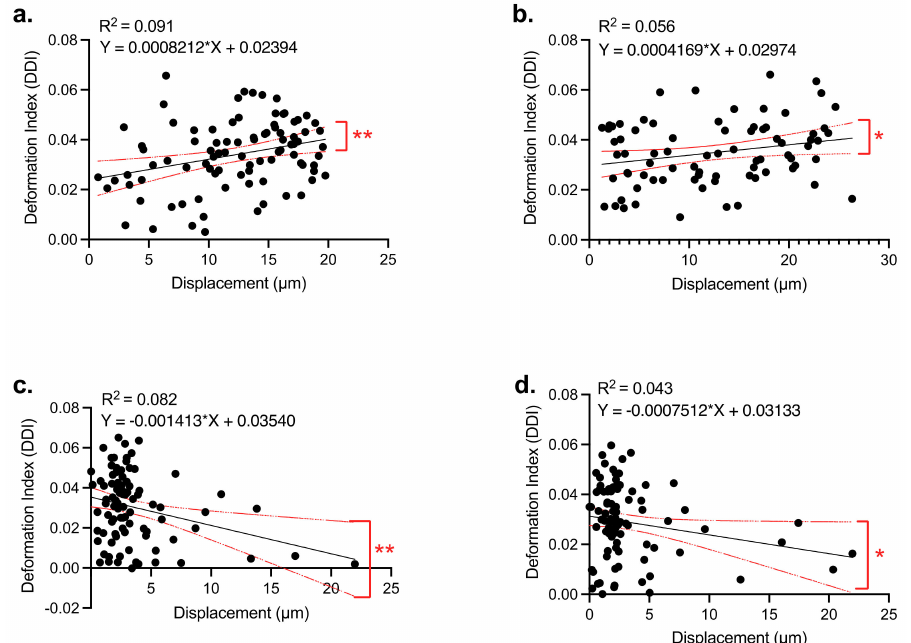
Figure 6. Linear regression between the deformation indexes and displacements of U87 glioma cells. When 3 V pp and ( a ) 50 kHz, ( b ) 90 kHz, ( c ) 400 kHz, and ( d ) 500 kHz electric field was applied. Simple linear regression test was applied. n =100 cells at each frequency, * = p < 0.05, ** = p <